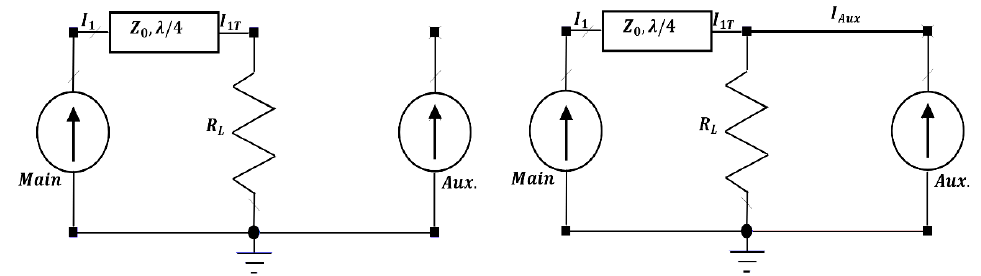
Figure 2. Equivalent circuit of Doherty amplifier ( a ) at low power region and ( b ) at medium and high power region [9].